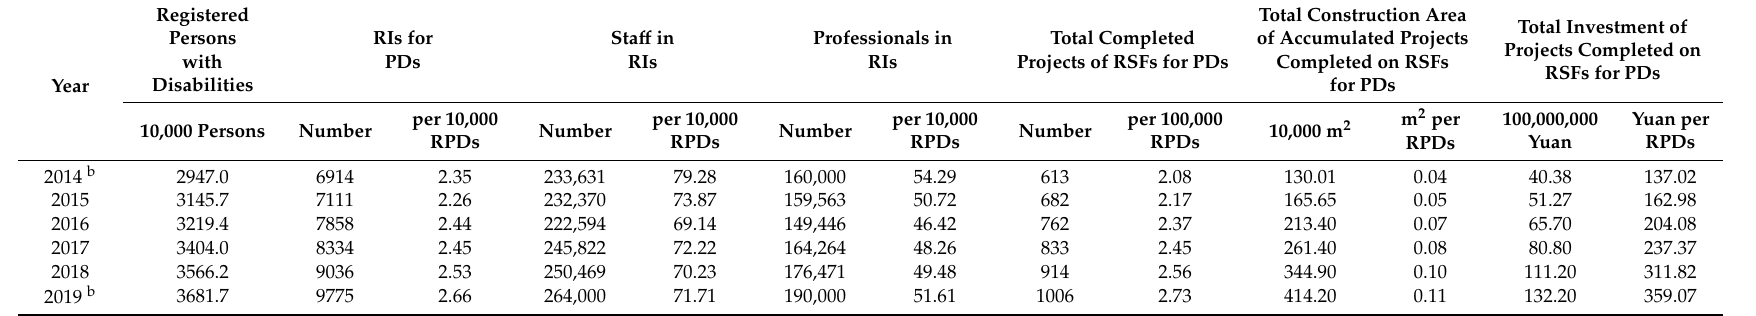
Table 1. Rehabilitation resources for PDs in China from 2014 to 2019 a